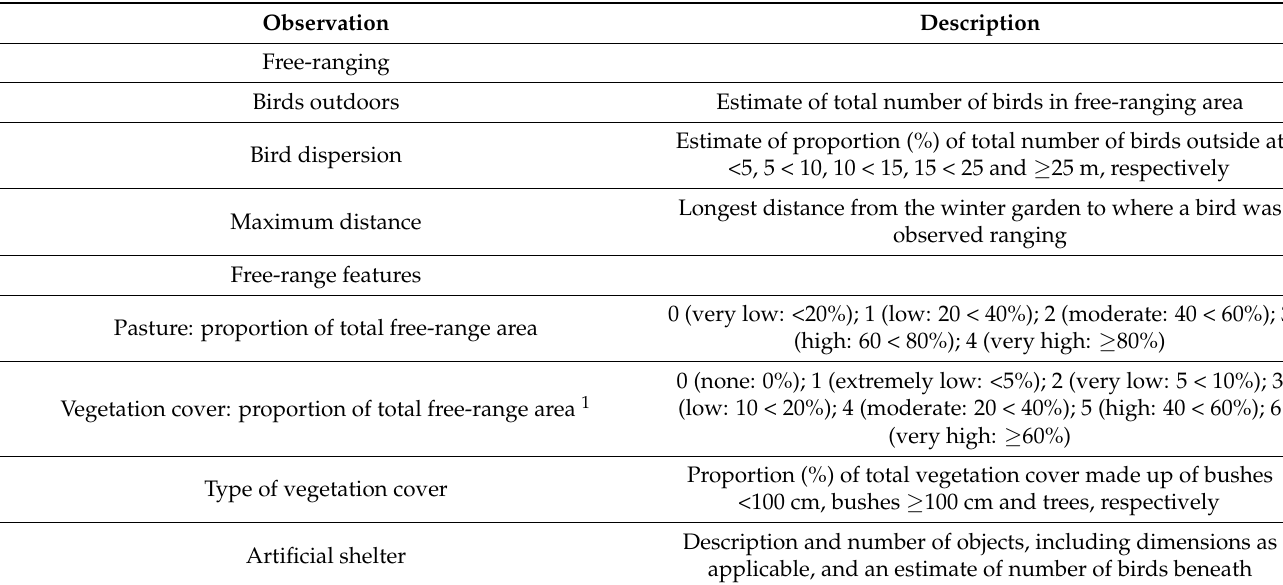
Table 2. Protocol used for free-range observations (ranging behaviour and vegetation) on Swedish organic broiler chicken farms. Free-range area not including winter garden.